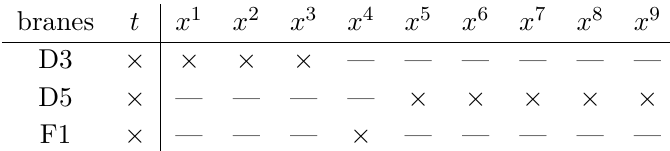
Table 6 . Brane set-up associated to the D3-D5-F1 brane configuration that describes Wilson loops in antisymmetric representations of 4d U( N ) N = 4 SYM.